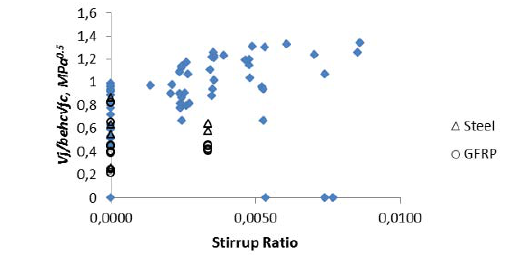
Figure 13. Influence of concrete cylinder strength.